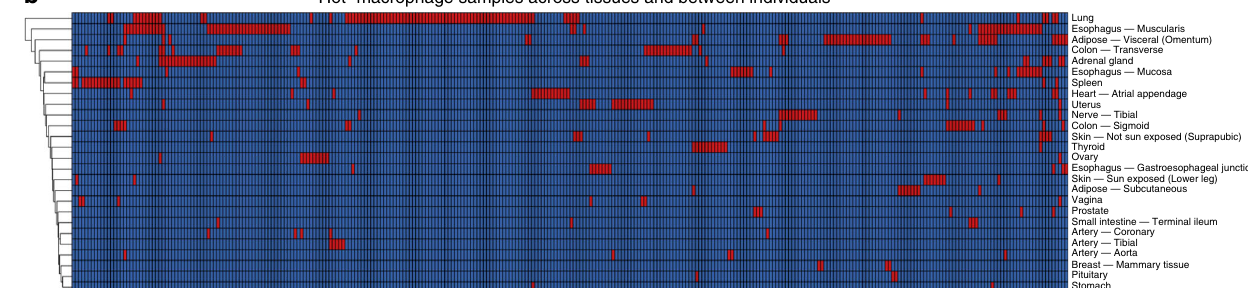
Fig. 3 Identi fi cation of hot and cold in fi ltration patterns. a Stacked heat maps depicting an in fi ltration phenotype: the immune cell scores for a particular tissue, as estimated across the 3 deconvolution algorithms. Samples are in columns, with the ordering of samples along the x -axis identical for the 3 heatmaps. Blue, yellow, and red colors correspond to low to moderate to high estimated scores. Annotations assigning samples to hot, cold, and intermediate clusters are depicted along the top of each heatmap. In this example, cluster assignments were determined using consensus k-means clustering. Samples identi fi ed as hot or cold across each of the 3 deconvolution methods were identi fi ed as the “ consensus ” hot and cold groups, and considered for differential gene expression analysis. b Heatmaps display hot patterns across tissues and individuals. Clusters were determined by the consensus k-means clustering approach. Rows represent tissues and columns represent individuals. Red indicates the individual was labeled hot in that tissue type, while blue represents not hot (intermediate, cold, or missing data since an individual does not have a sample for every tissue type). Row and columns were clustered by Euclidean distance. Source data are provided as a Source Data fi